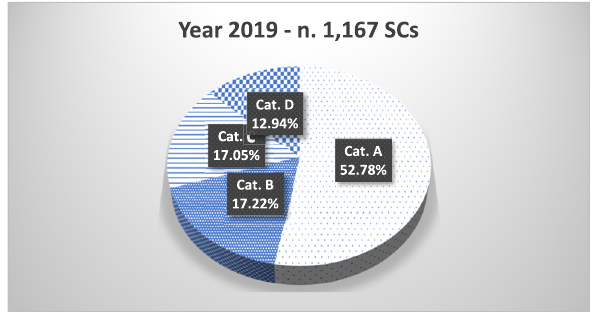
Figure 2: Percentage frequency by categories, year